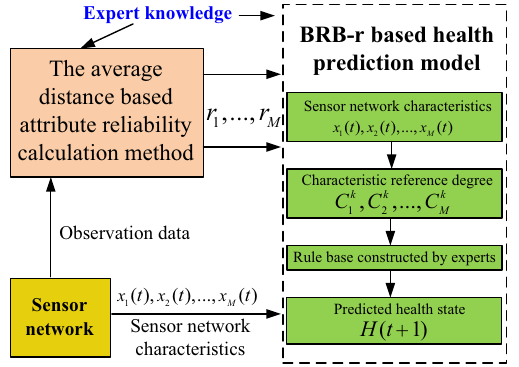
Figure 1. BRB-r based health prediction model for a sensor